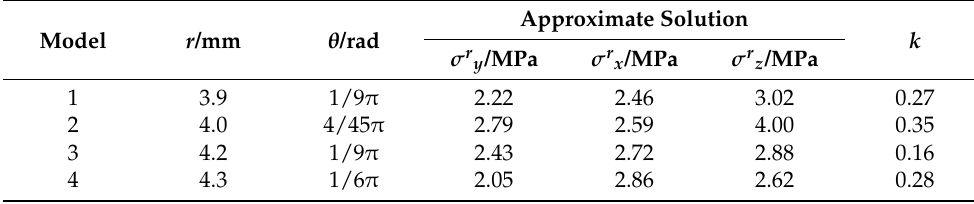
Figure 16. Curved surface diagram of origami honeycomb cushioning capacity when ( a ) k ≤ 0.1, ( b ) k ≤ 0.15, ( c ) k ≤ 0.2, and ( d ) k ≤ 0.3. Table 4. Ten examples of origami honeycomb with 0.15 ≤ k ≤